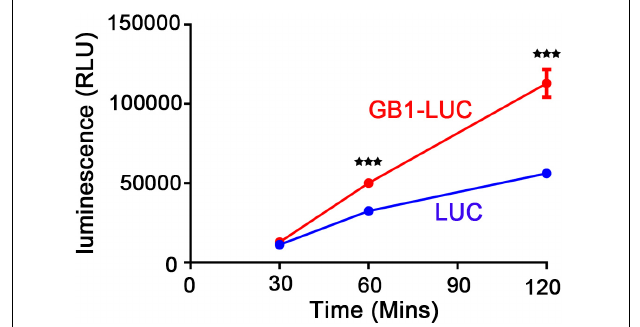
FIGURE 4 | GB1 fusion leads to an enhanced translation rate in vitro . LUC and GB1-LUC were transcribed and translated in vitro in wheat germ extracts. During the reaction, 5 µ l were taken from the 50 µ l reaction volume at 30, 60, and 120 min and diluted 24-fold. The RLUC activity was measured using the Renilla Luciferase Assay System. Three independent translation reactions were carried out. The error bar is the mean ± SD ( n = 3). Asterisks indicate a significant difference (Student’s t -test; three asterisks, P < 0.001).